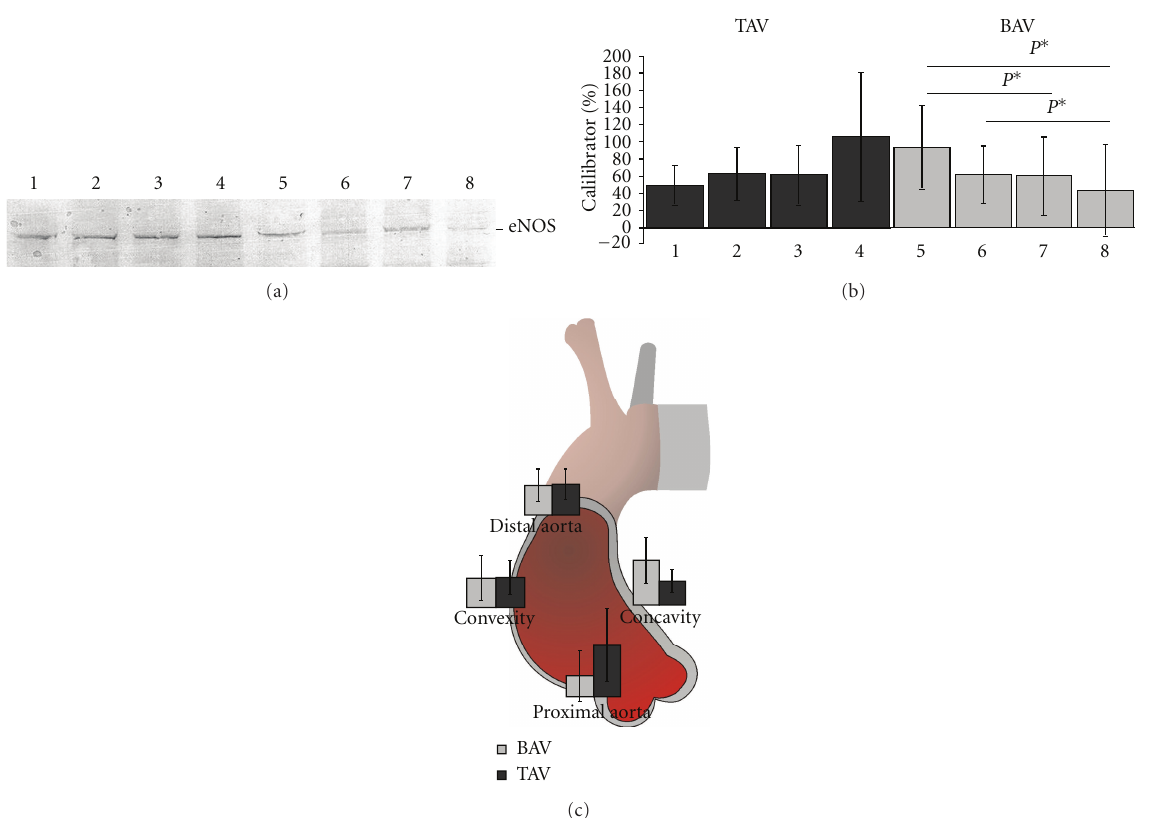
Figure 1: (a) Representative western blot of pooled cell lysate from 4 TAV and 4 BAV patients. 1: TAV concavity; 2: TAV distal aneurysm; 3: TAV convexity; 4: TAV proximal aneurysm; 5: BAV concavity; 6: BAV distal aneurysm; 7: BAV convexity; 8: BAV proximal aneurysm. (b) The eNOS protein level ± SD in di ff erent aortic areas was determined by densitometry. 1: TAV concavity; 2: TAV distal aneurysm; 3: TAV convexity; 4: TAV proximal aneurysm; 5: BAV concavity; 6: BAV distal aneurysm; 7: BAV convexity; 8: BAV proximal aneurysm; P ∗ : P < 0 . 05; TAV: n = 5; BAV: n = 14. (c) eNOS protein levels in di ff erent areas of TAV and BAV aneurysmal aorta. Mean levels of eNOS protein amounts ± SD are given for each aortic area. Di ff erences between eNOS protein levels of TAV ( n = 5) and BAV ( n = 14) in the proximal aneurysmal aorta are significant with P = 0 . 04.